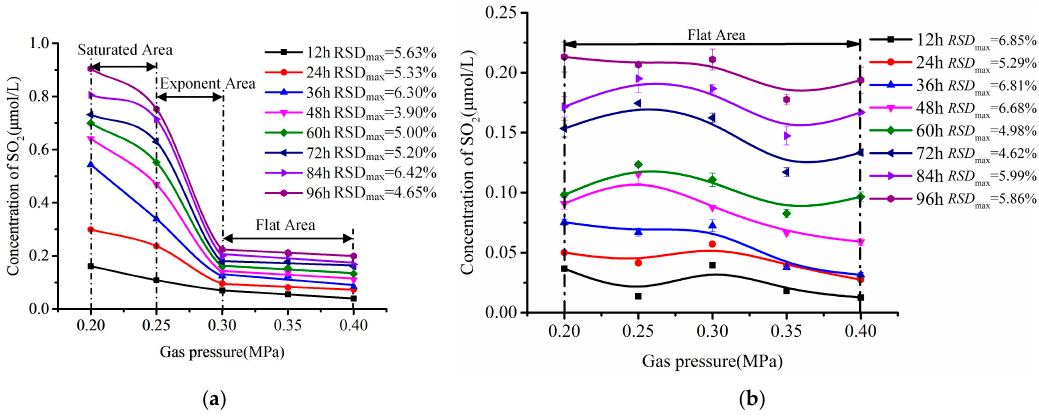
Figure 5. Correlation between SO 2 concentration and pressure: ( a ) Protrusion and ( b )